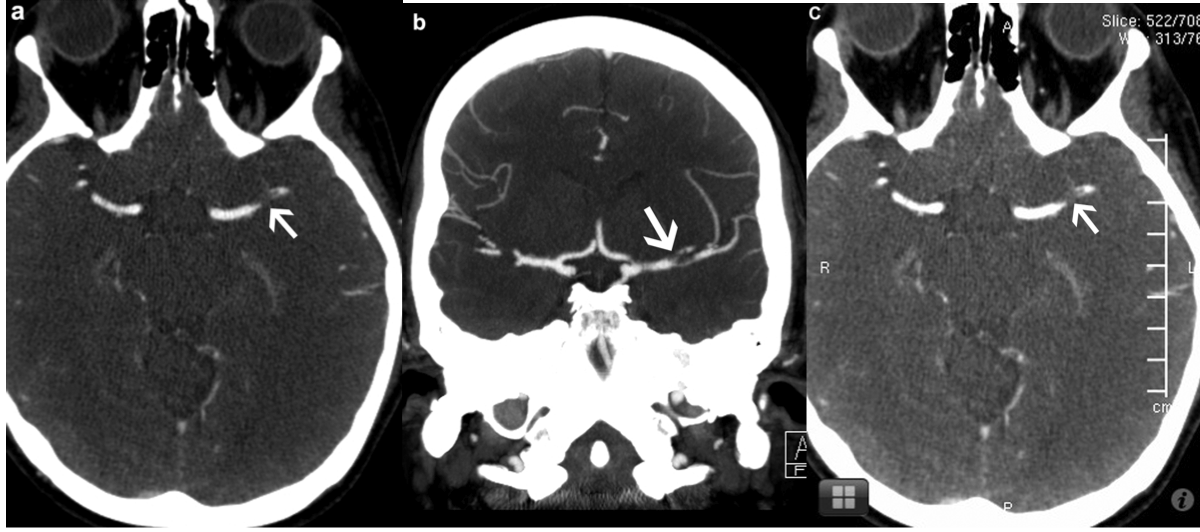
Figure 4. The workstation monitor axial and coronal images a and b show acute thrombus (arrow) in the proximal segment of the left MCA. Corresponding iOS device axial image c shows acute thrombus (arrow) in the proximal segment of the left MCA.